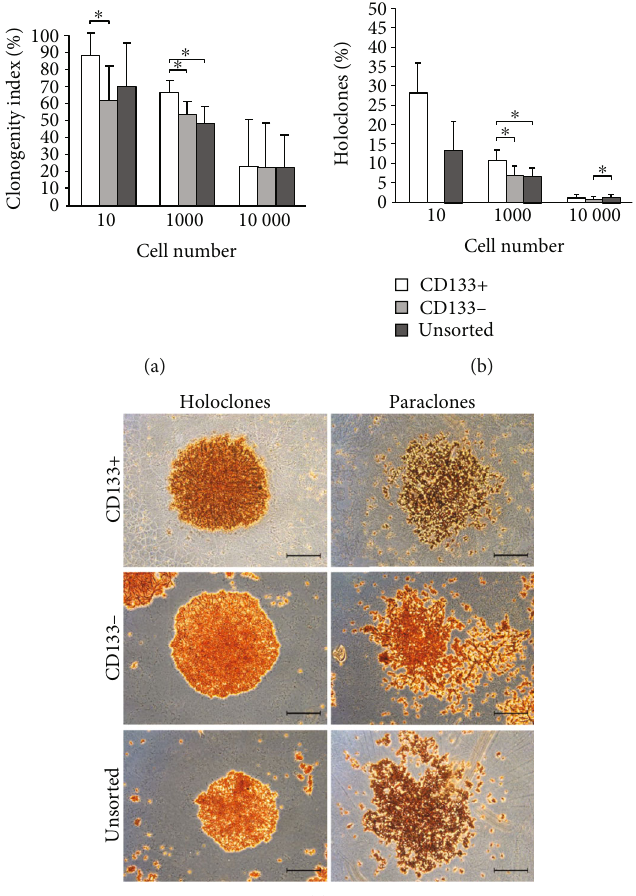
Figure 3: Clonogenity assay: (a) clonogenity index depending on the B16-F10 cell population (CD133+, CD133-, CD133+/-) and the cell number ( p < 0 : 05 ); (b) percentage of holoclones generated by tested cell populations ( p < 0 : 05 ); (c) holoclones and paraclones morphology depending on the phenotype of the tested cells, inverted microscope, bar = 400 μ m .